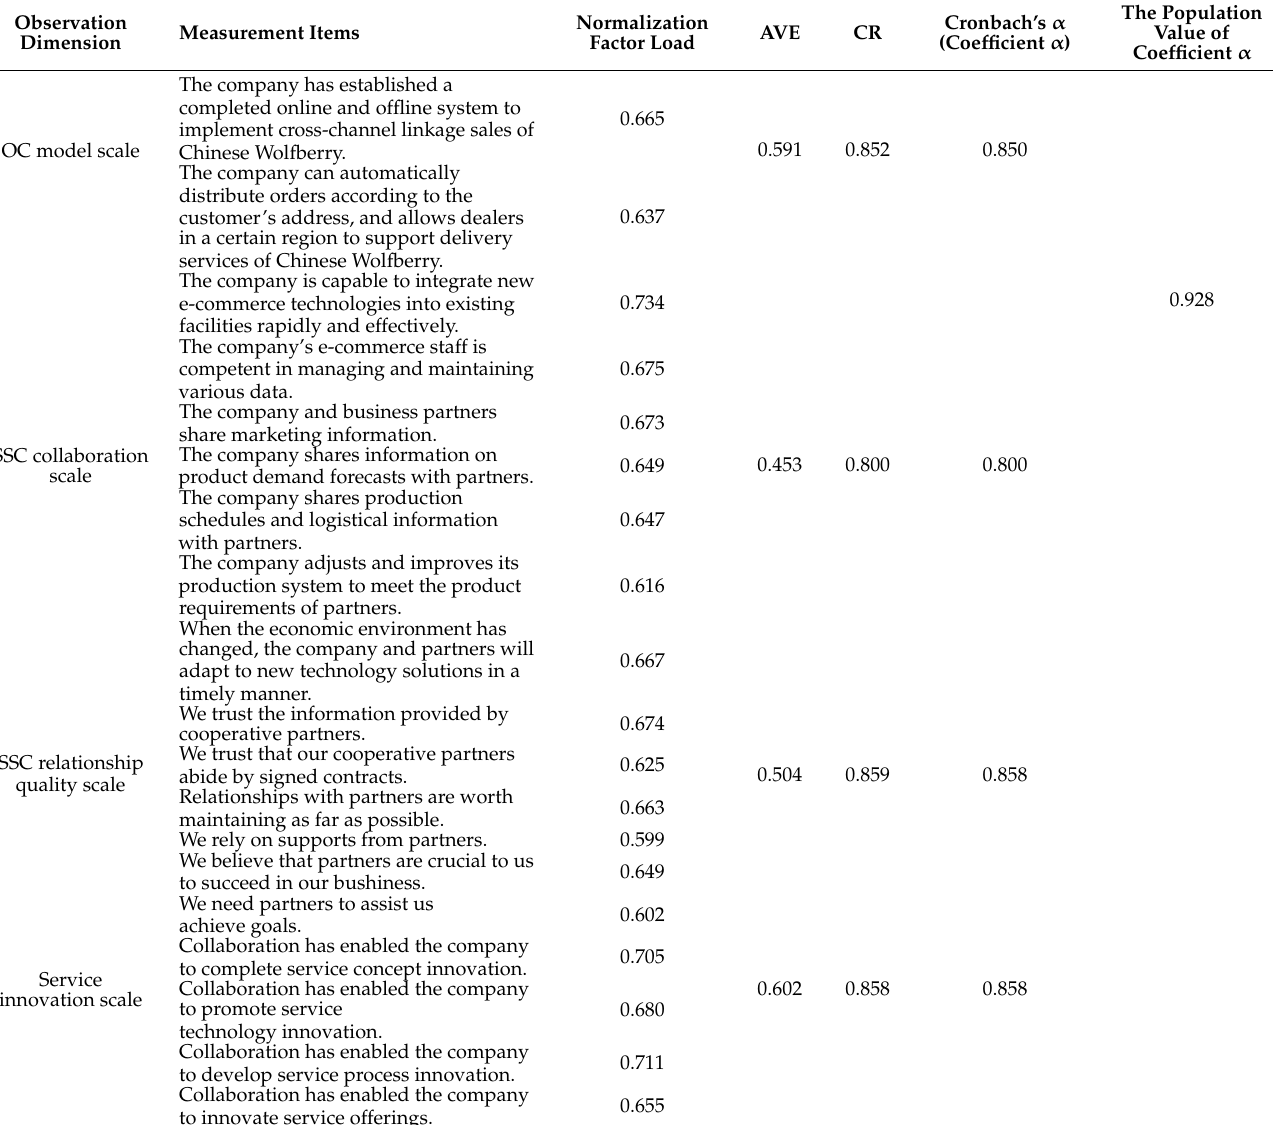
Table 2. Reliability and validity analysis of the scale.